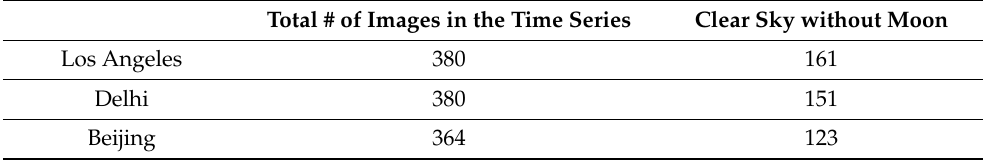
Table 1. SNPP/VIIRS/DNB images used in this study. Total # of Images in the Time Series Clear Sky without Moon